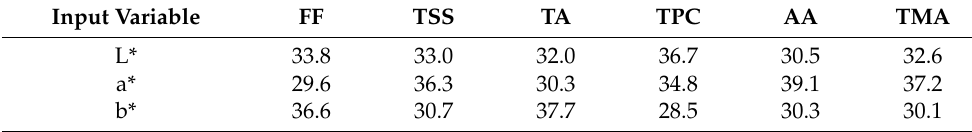
Table 5. Relative importance (%) of the input variables to ANN model